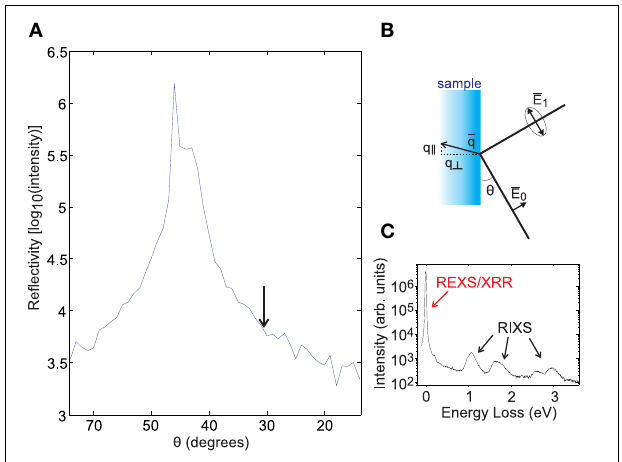
FIGURE 1 | Elastic line and specular reflection. (A) Elastic scattering intensity as a function of θ , the angle between the incident beam and a NiO sample surface, in the 90 ◦ scattering geometry shown in (B) . Incident polarization is inside the scattering plane, and most specular reflection intensity is found near θ = 45 ◦ . (C) The relative intensity of the elastic scattering (REXS) and inelastic excitations on resonance (i.e., M-edge RIXS) is shown for the slightly grazing scattering geometry indicated by the arrow in (A)